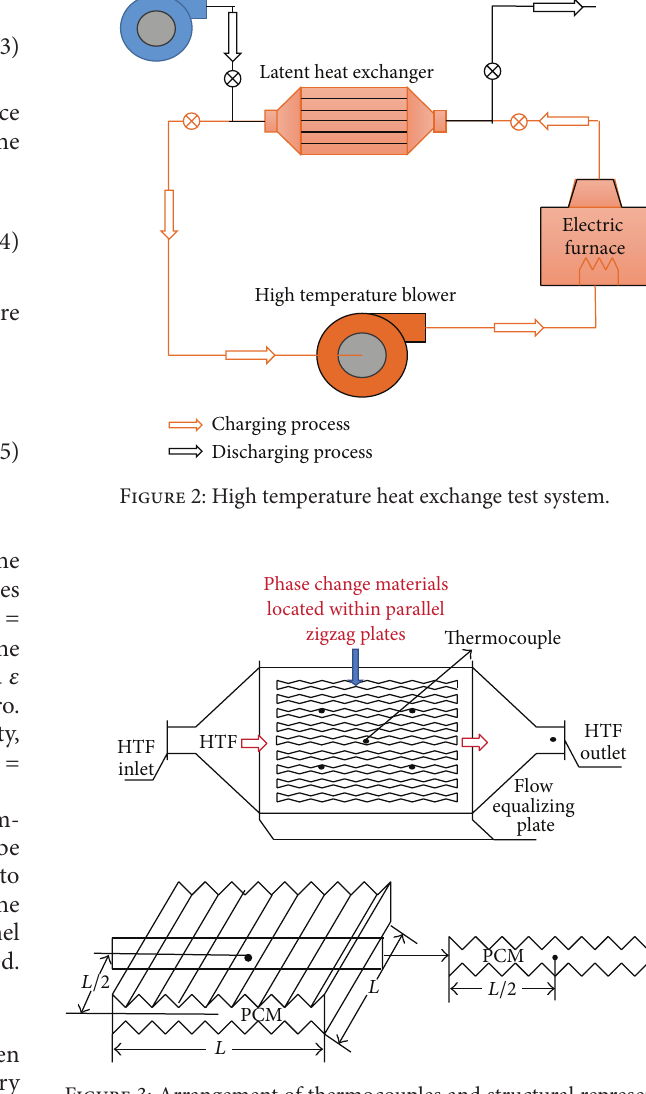
Figure 3: Arrangement of thermocouples and structural represen- tation of zigzag